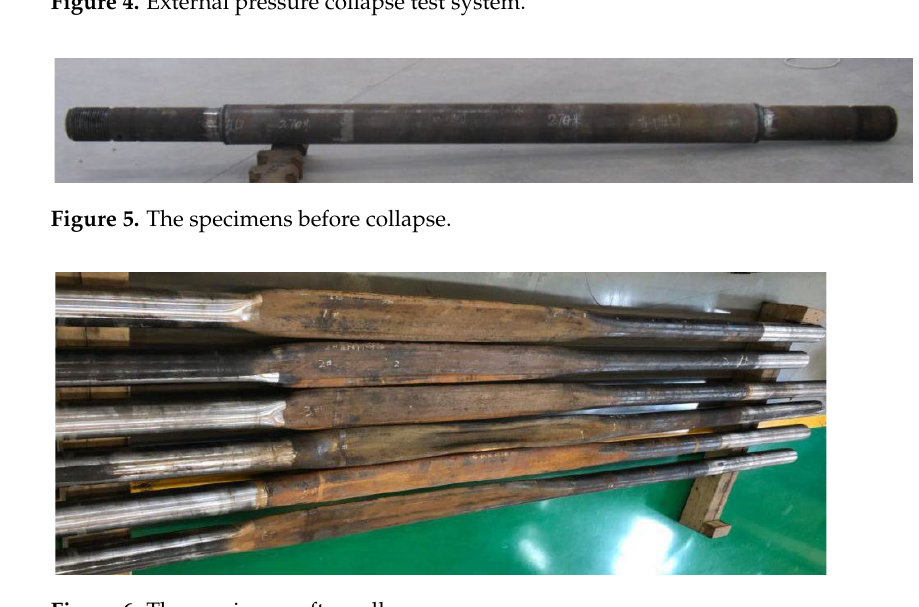
2413 In order to increase the validity of data, here, the min-max (Min-Max Normalization) standardized data consistency processing method will be selected. This method, also called deviation standardization, is a linear transformation of the original data, so that the result value is mapped to [0– 1]. The conversion function is as follows: